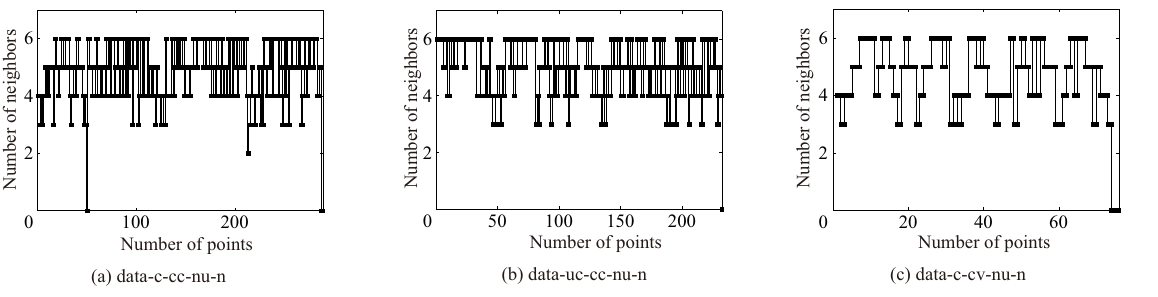
Fig. 3 Number of natural neighbors.